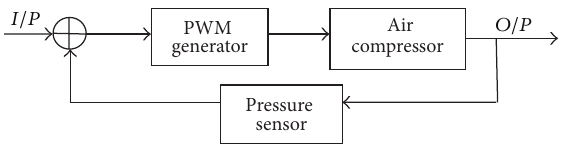
Figure 13: Closed loop feedback control system.